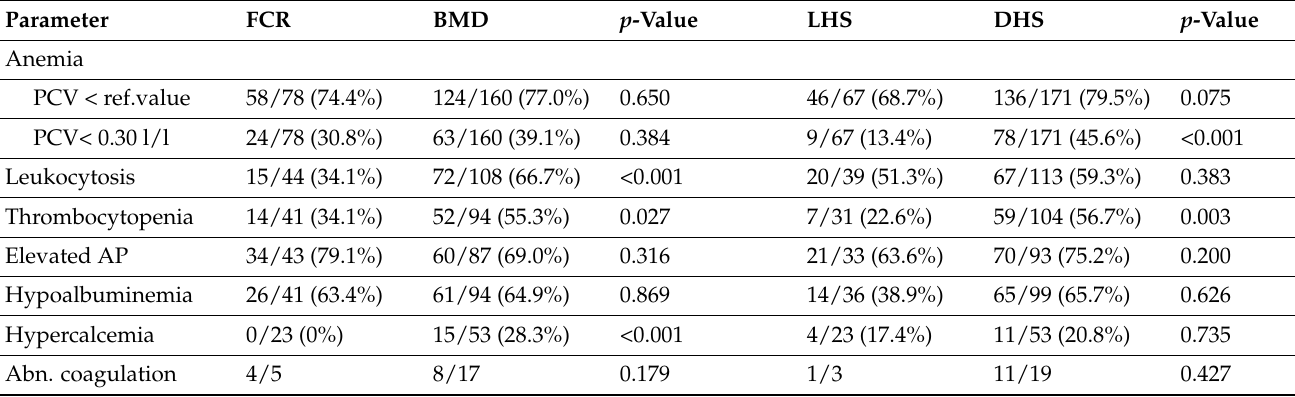
Table 3. Blood results differentiated for breed (FCR vs. BMD) and type of HS (LHS vs.